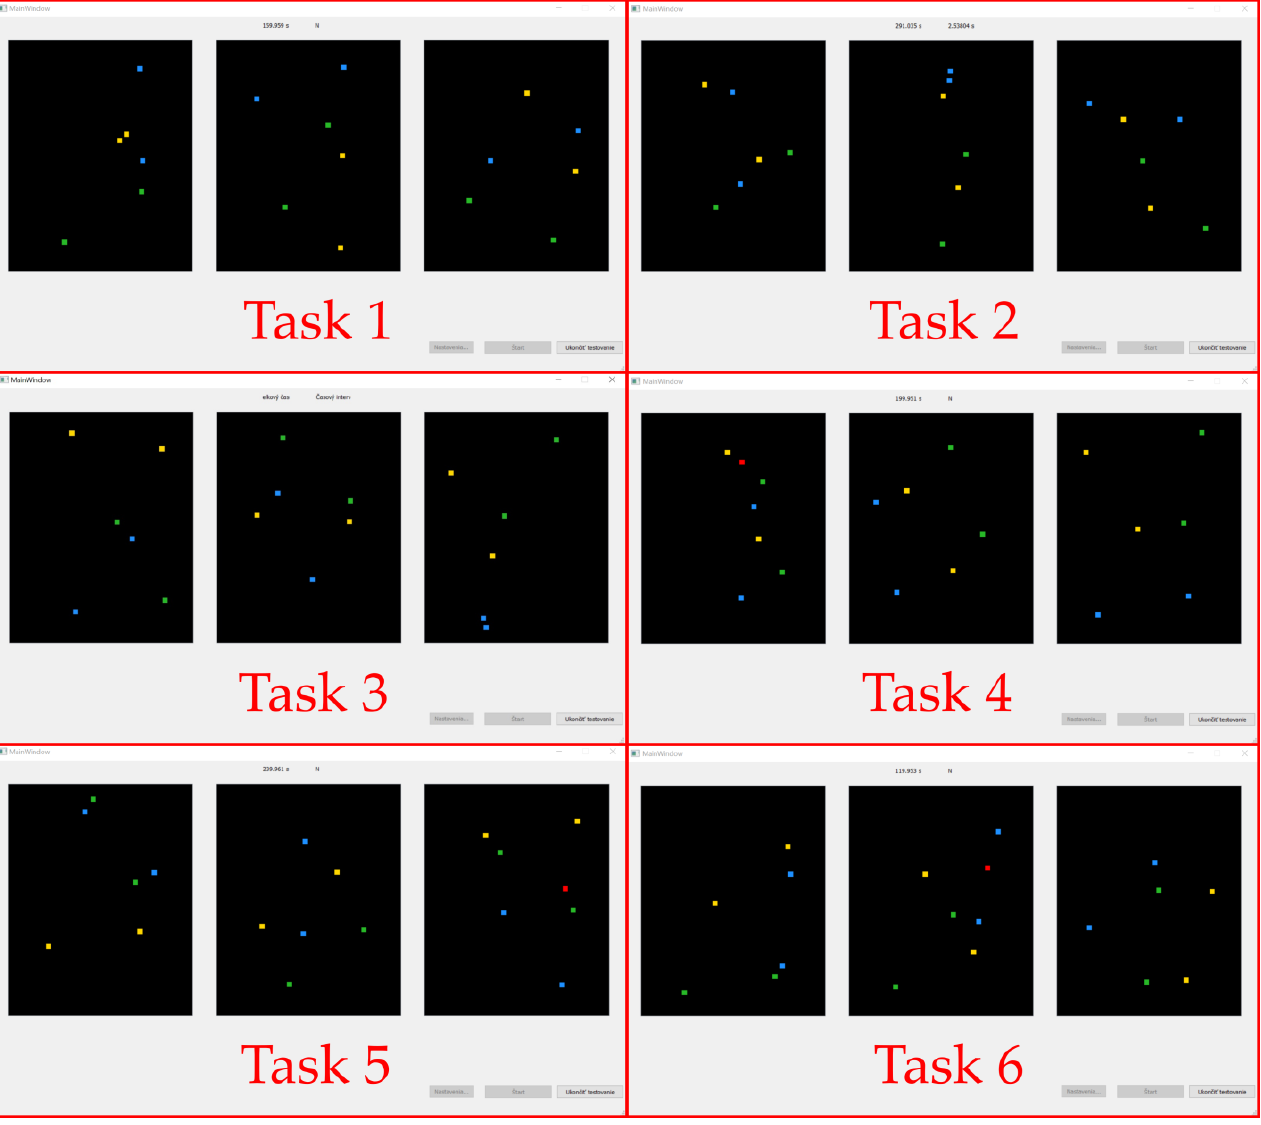
Figure 9. Kind of tasks during testing.